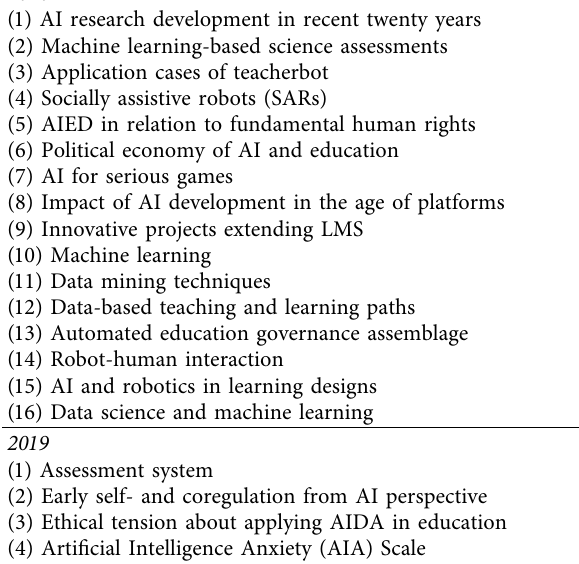
Table 3: Qualitative research